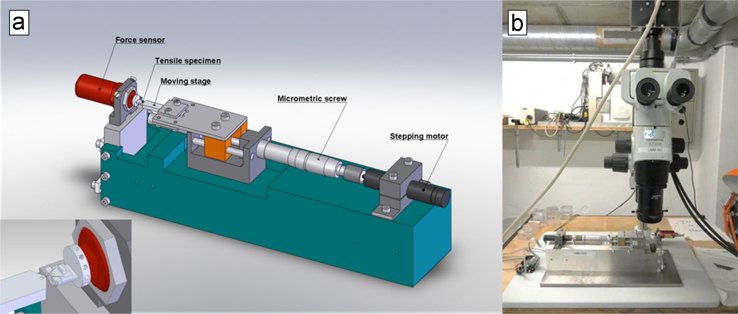
a) Illustration of tensile bench with inset showing the gauge area. b) The tensile bench as mounted beneath a binocular and camera [3].